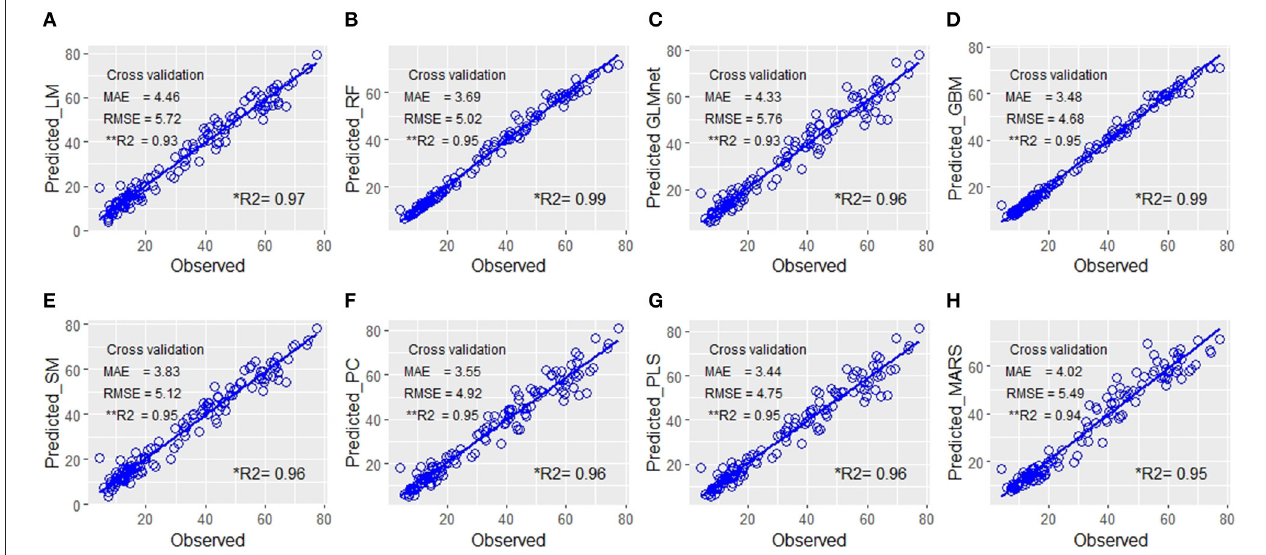
FIGURE 2 | Quantitative relationship between the predicted fresh biomass (PFB) from image-features and the observed plant fresh biomass. Scatter plots of the manually measured plant biomass (fresh weight) vs. predicted biomass values using eight prediction models: (A) linear model (LM), (B) random forest RF, (C) GLMnet, (D) gradient boosting machine (GBM), (E) step model (SM), (F) principal component (PC), (G) partial least square (PLS), and (H) multivariate adaptive regression x ). The prediction models were evaluated by mean absolute error (MAE), root mean square error splines (MARS). The blue line indicates the expected prediction ( y = (RMSE), and the percentage of variance explained by the models (the coefficient of determination R 2 ). Each figure in the panel has ** R 2 values computed as the mean of R 2 of repeated sampling of data and is a more realistic estimate of power of prediction of the model with a new set of data in comparison to the conventional * R 2 value derived from the regression equation using a whole set of predicted values without